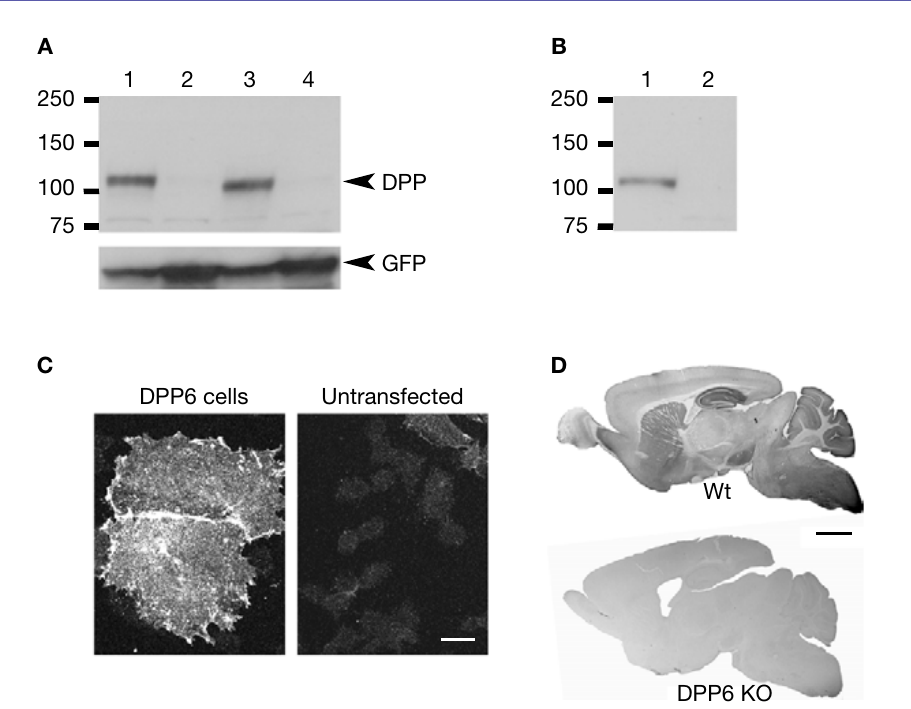
Figure 2 | Specifi city of antibodies against DPP6 proteins. (A) DPP6 antibodies detected a band of approximately 115 kD in immunoblots of extracts from CHO cells transfected with DPP6-S (lane 1) or DPP6-L (lane 3). The antibodies were specifi c for detection of DPP6 proteins, since no bands were detected in extracts from non-transfected cells (lane 2) or cells transfected with DPP10 (lane 4). All cells were also transfected with GFP to control for transfection effi ciency. (B) DPP6 antibodies detected a band of similar size in immunoblots of brain membranes obtained from wild type mice (lane 1) but not from DPP6 knockout mice (lane 2). (C) Immunofl uorescent detection of DPP6 protein in DPP6-transfected CHO cells (left panel). No labeling is observed in untransfected CHO cells (right panel). Note that, as previously reported, transfection with DPPs produces fl attening of CHO cells (Nadal et al., 2003; Zagha et al., 2005). (D) DPP6 antibodies labeled several brain structures in wild type mice. Immunoperoxidase staining was reduced to background levels in DPP6 knockout mice. Scale bar: 10 μ m (C) ; 2 mm (D)